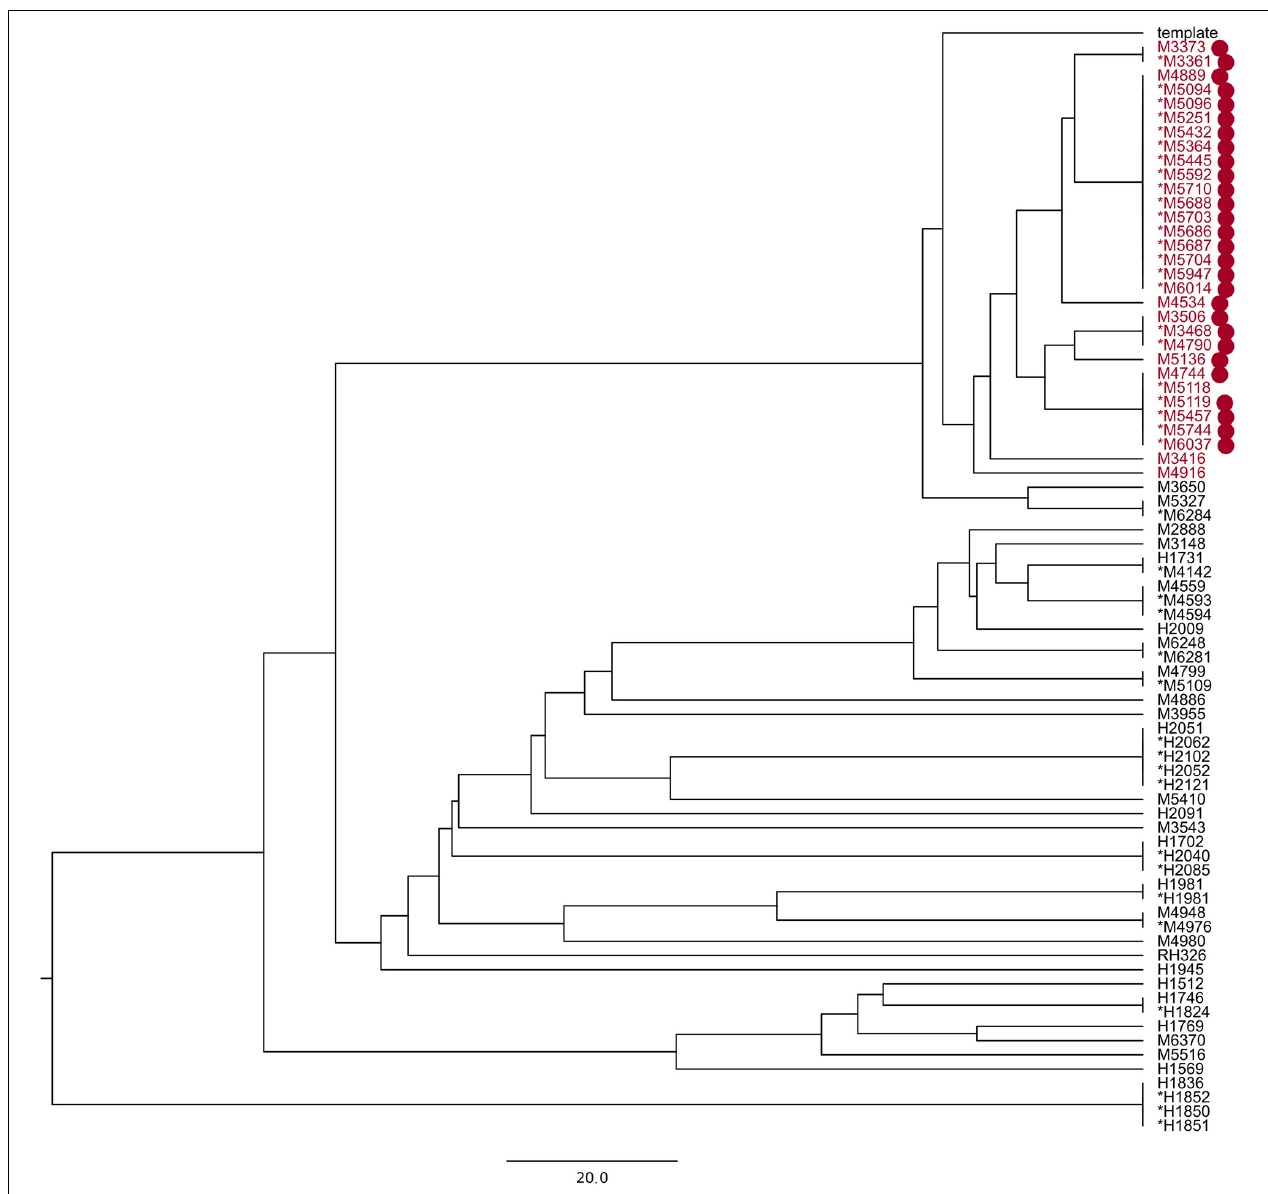
FIGURE 3 | UPGMA phylogenetic tree made with reference Staphylococcus aureus M3261; the samples in red are part of a known hospital outbreak, with supporting epidemiological data denoted with red dots. The asterisk denotes samples in the technical clusters. The scale bar is the equivalent of 20 SNPs.